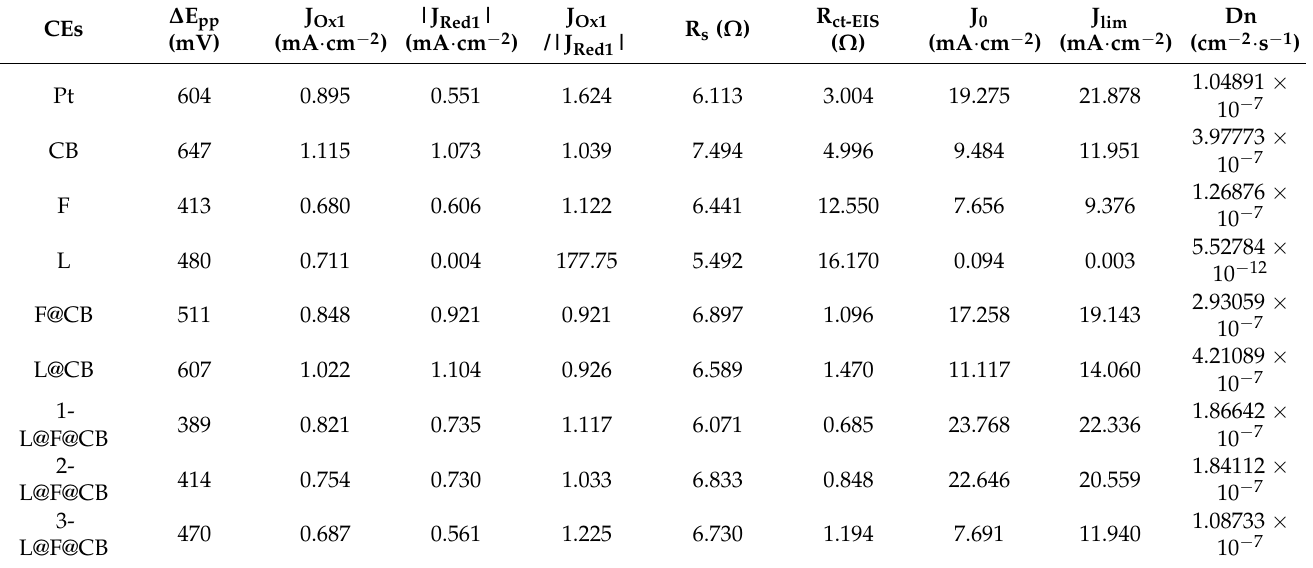
Table 2. CV, EIS, and Tafel polarization parameters for different